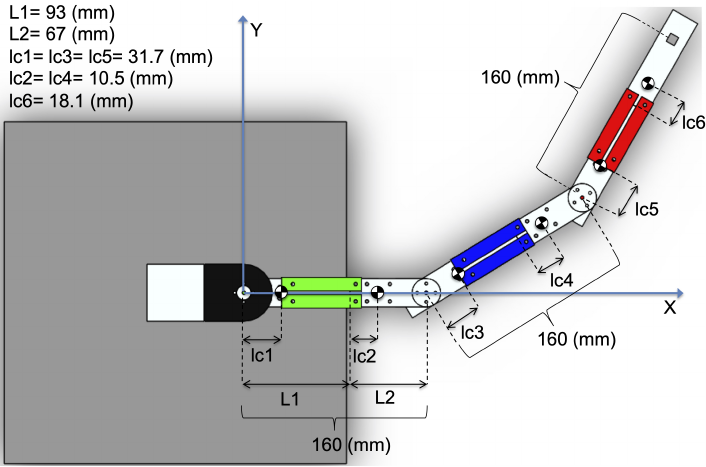
Figure 2. Resting location and position of the mass centers of the 6